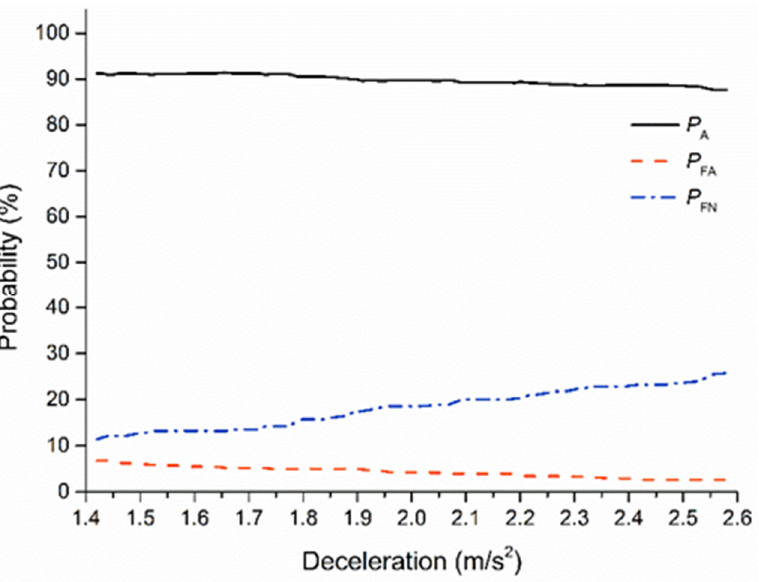
Figure 12. SDT for the second safe threshold (ST 2 ).